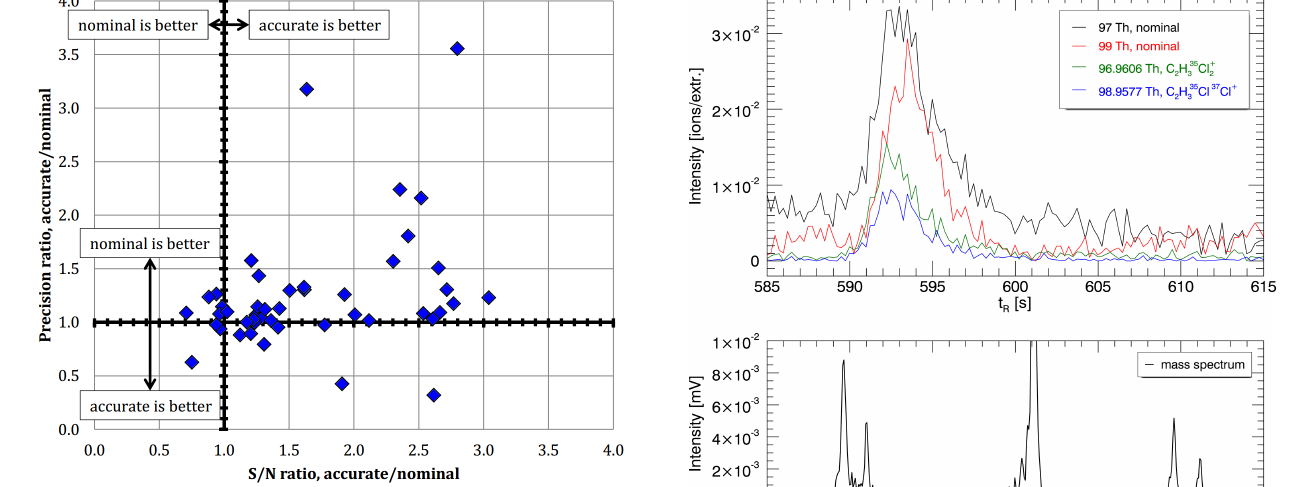
Figure 6. Corresponding ratios of signal-to-noise ( x axis) and measurement precision ( y axis) of values determined with accurate mass intensities relative to values determined with nominal mass intensities. Each diamond represents a substance which was evaluated on both nominal and accurate masses. Data based on repeated measurements of the same reference gas at constant sample volume of about 0.66L, see Fig. 5. While S/N is improved for almost all substances using the accurate mass intensities, a slight decrease in measurement precision is observed compared to values derived with nominal mass intensities.